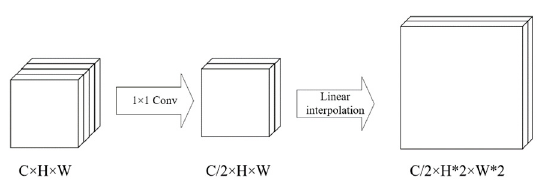
Figure 8. The upsampling module restores the input tensor process.